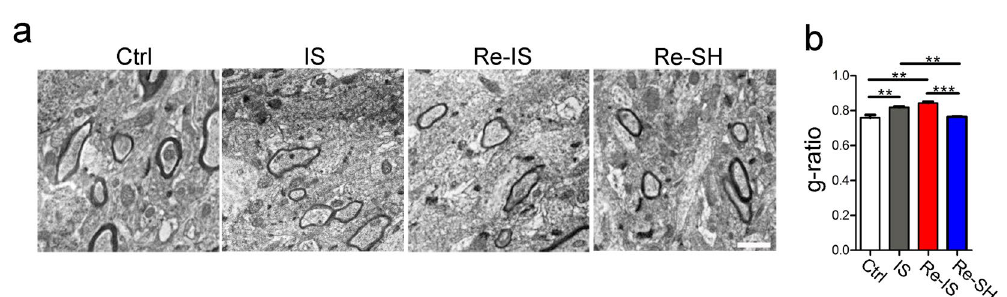
Figure 3. The powers of β - and γ -oscillation in the medial prefrontal cortex (mPFC) are dependent on the mode of re-socialization. The powers of δ -, θ -, α -, σ -, β -, and γ -oscillation in the m PFC during exposure to a strange mouse for 5 min (relative to baseline) were measured. ( a – d ) The power of either δ -, θ -, α -, or σ -oscillation was not different between Ctrl, Re-IS, and Re-SH mice. ( e ) The power of β -oscillation was markedly increased in Re-IS mice as compared to Ctrl and Re-SH mice. ( f ) The increase in γ -oscillation power in Re-IS mice was significantly less than that in Ctrl and Re-SH mice, while the amount of change in Re-SH mice was less than that in Ctrl mice. n = 3/group, * p < 0.05, ** p < 0.01, *** p < 0.01. Error bars = SEM.